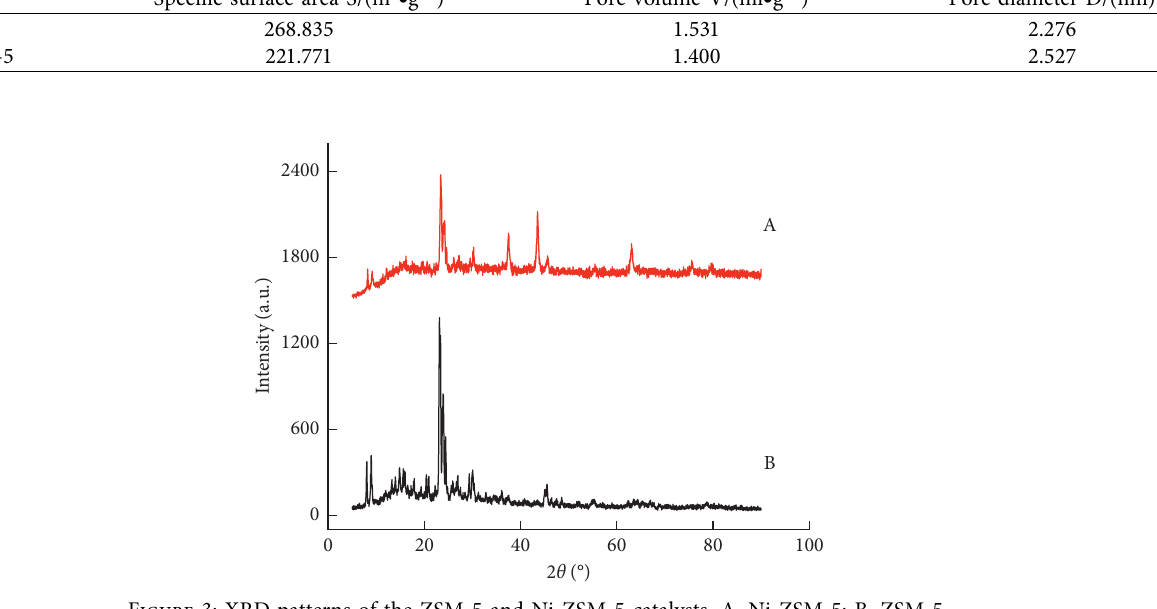
Figure 3: XRD patterns of the ZSM-5 and Ni-ZSM-5 catalysts. A. Ni-ZSM-5; B. ZSM-5.